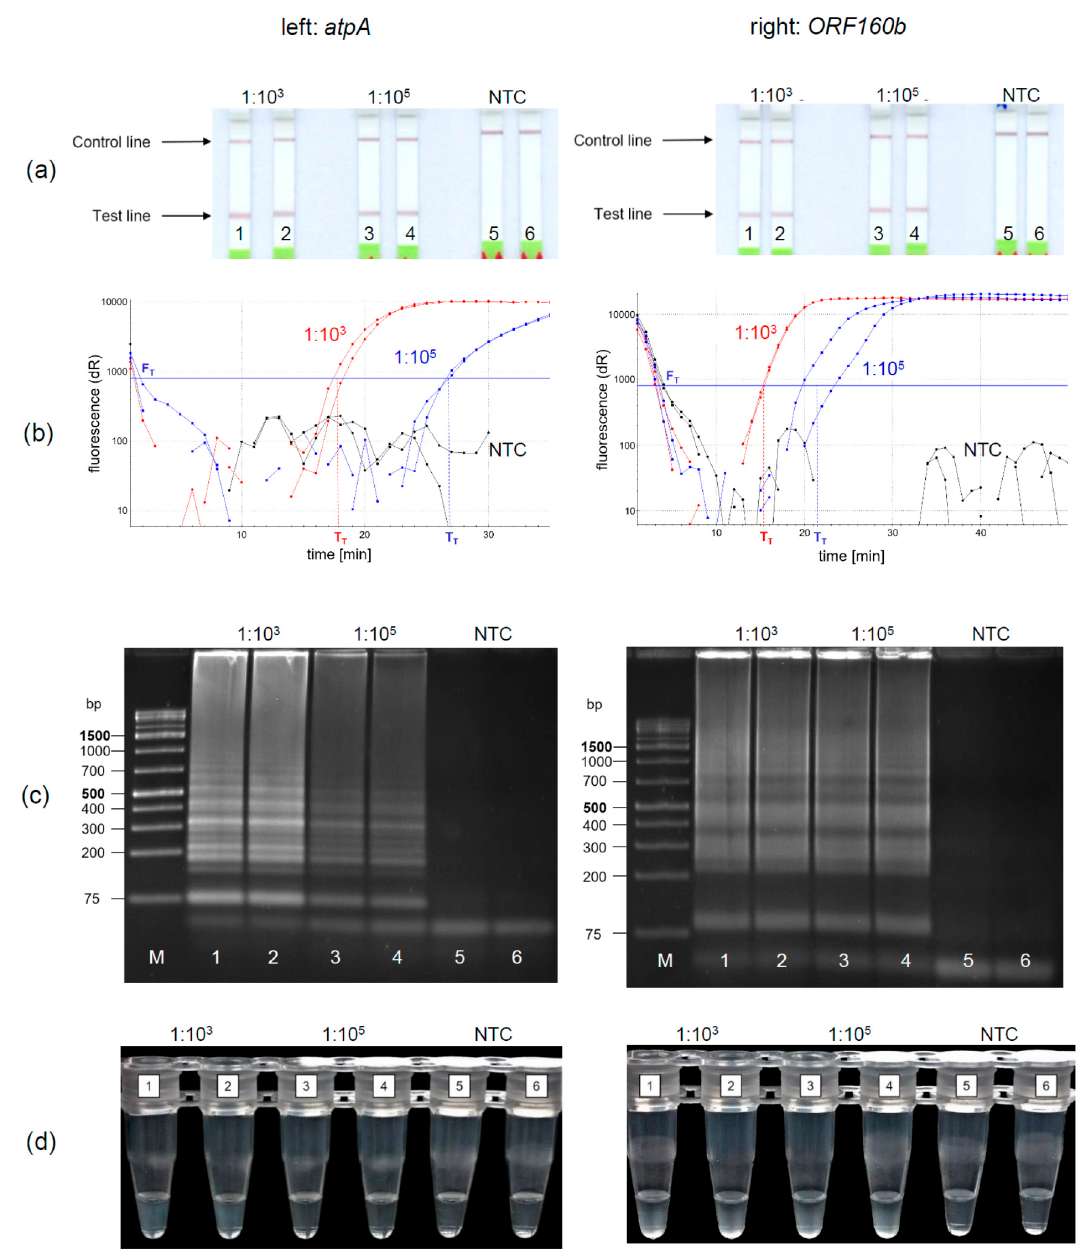
Figure 3. Duplicate detection of LAMP DNA products of the optimized atpA (left) and ORF160b (right) LAMP assays using ( a ) the lateral flow dipstick (LFD); ( b ) real-time fluorescence based on SYBR Green I; ( c ) agarose gel electrophoresis (AGE); ( d ) visual inspection via turbidity formation. (B: red curves: 1:10 3 diluted DNA; blue curves: 1:10 5 diluted DNA; black curves: NTC).